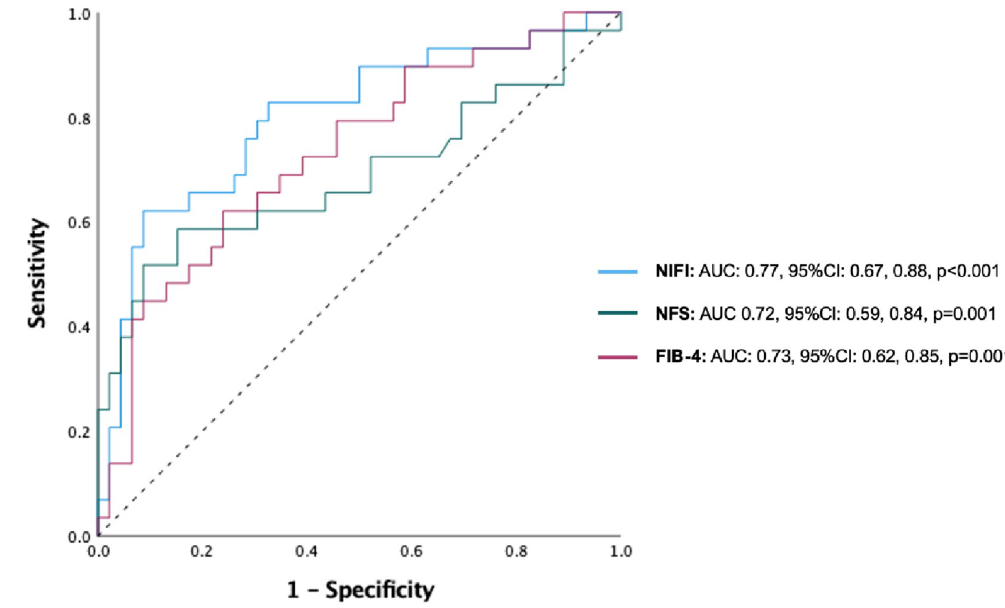
Fig 1. Receiver-operating characteristic (ROC) curves showing area under the curve (AUC) for 105 patients. The outcome of NAFLD severity (defined by Fibroscan score � 7.2 kPa) is tested against NAFLD fibrosis index (NIFI), NAFLD fibrosis score (NFS) and FIB-4